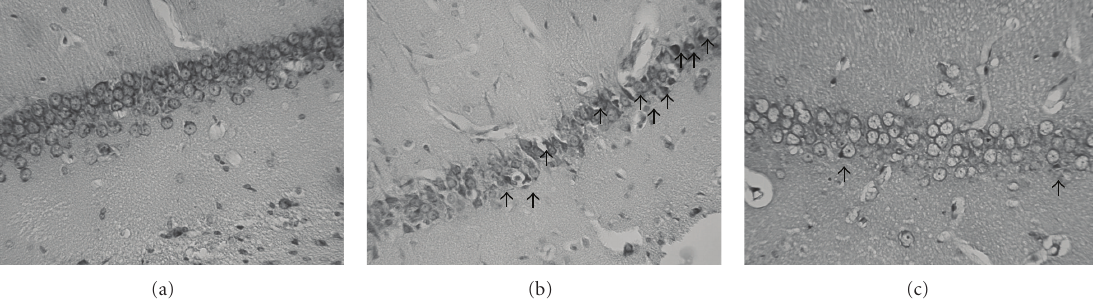
Figure 1: Microphotographs (20x) of pyramidal neurons in the CA1 region of the hippocampus. Sections from (a) sham-operated rat, (b) ischemic untreated, and (c) ischemic MSC-treated rat. Shrunken neurons are indicated by arrows. Images were obtained 5 days after ischemia.